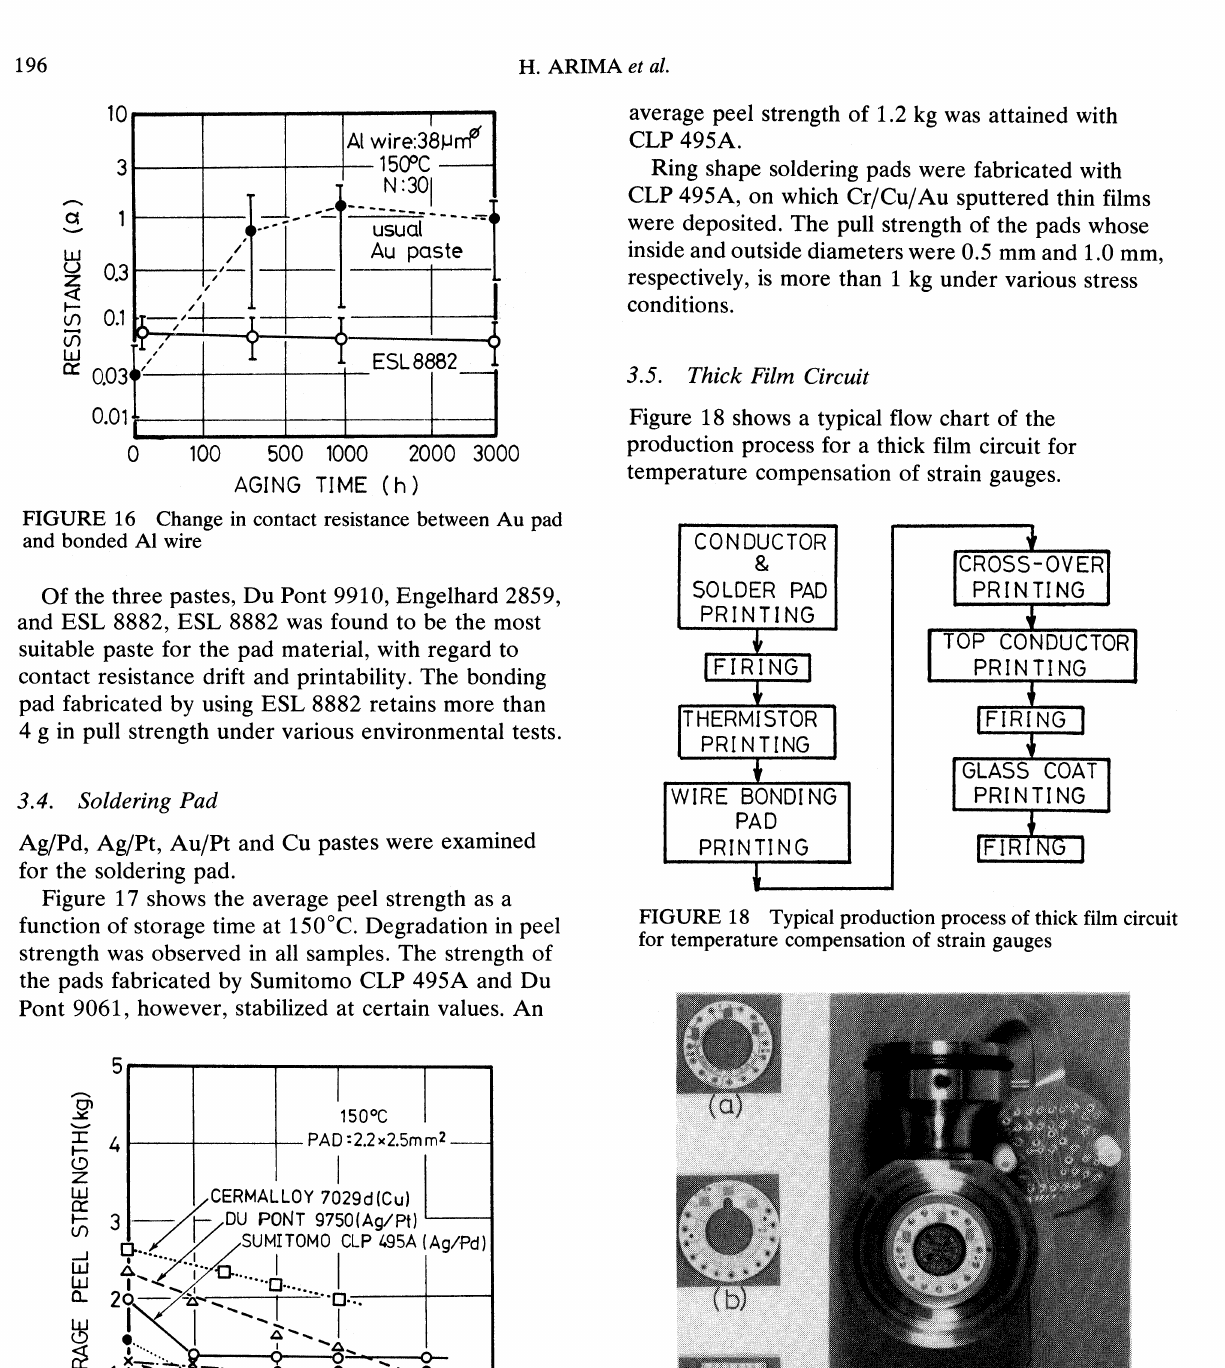
FIGURE 19 Thick film circuits and a pressure sensing part of a transmitter (a), (b): Thick film circuits for pressure transmitter (c): Thick film circuit for differential pressure